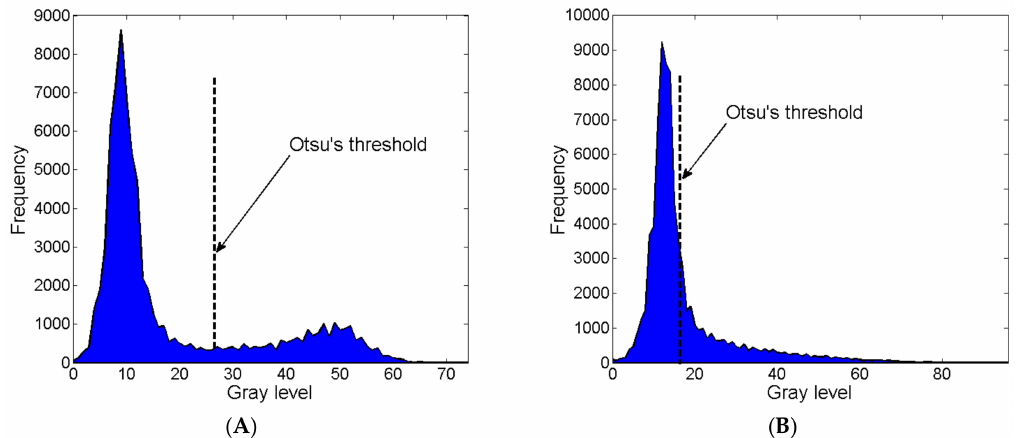
Figure 7. Sample location in the selection of Otsu’s threshold for ( A ) valley and ( B ) single peak